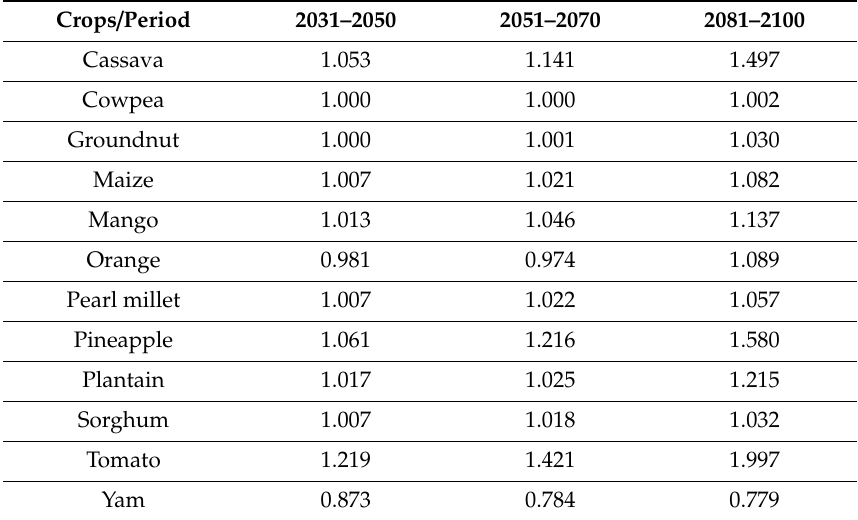
Table 4. Trends in the projected change in suitability over West Africa for the near future, mid and end of the century periods for di ff erent